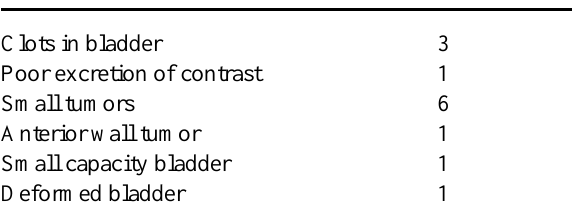
Table 1 – Failure of urography to detect bladder carcinoma (n = 13).